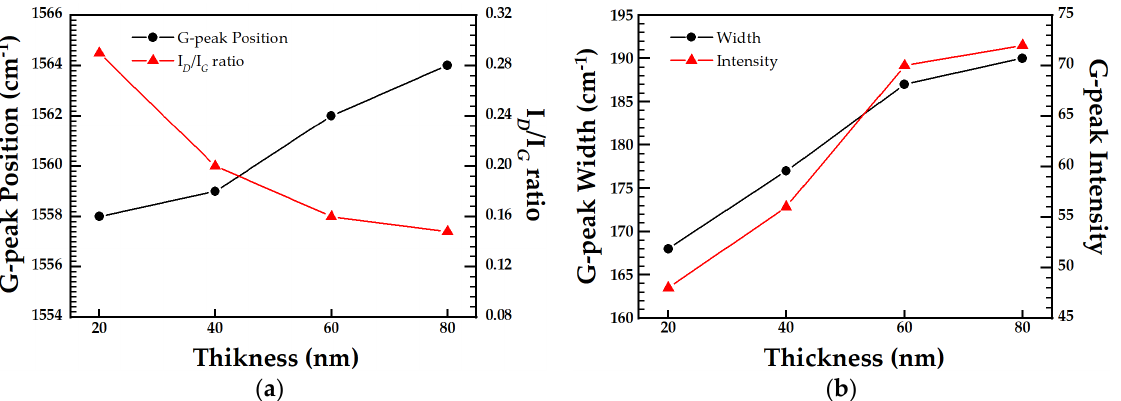
Figure 3. Contact angle ( a ) images and ( b ) values of the RF-PECVD DLC thin films with various film thicknesses: 20, 40, 60, and 80 nm.